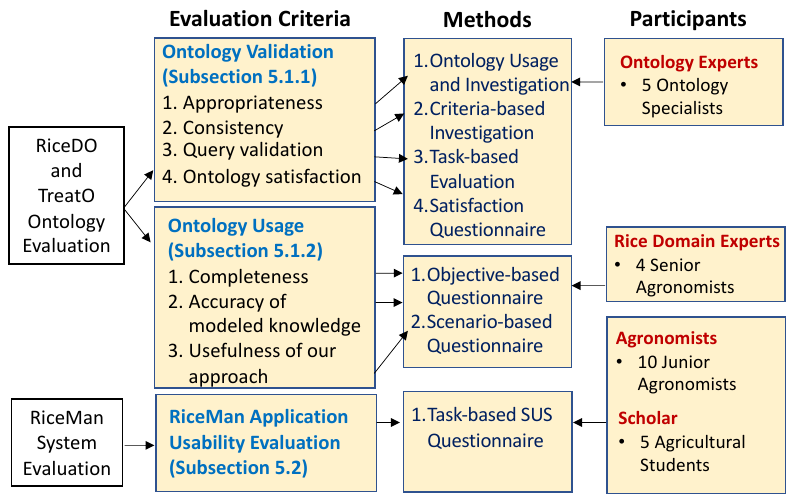
Figure 9. Our evaluation design for both ontologies and RiceMan (the evaluation criteria, the methods used by each evaluation and the specific participants are